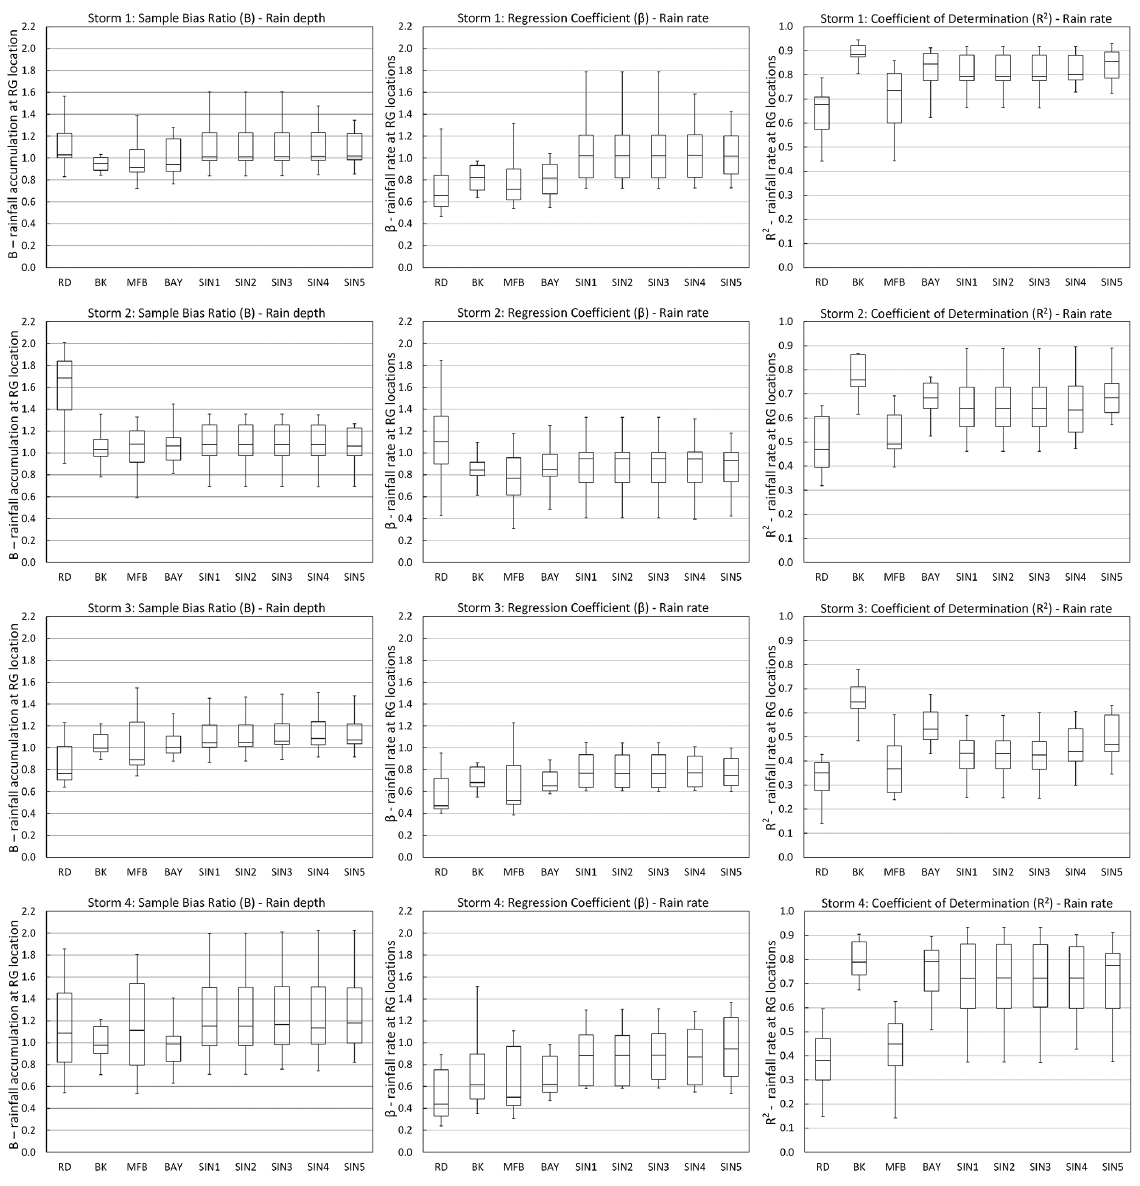
Figure 6. Boxplots displaying the distribution of sample bias ratio ( B ) (left column panels), regression coefficient ( β ) (middle column panels) and coefficient of determination ( R 2 ) (right column panels) estimated between the different gridded rainfall estimates and RG records at individual rain gauge locations following a cross-validation